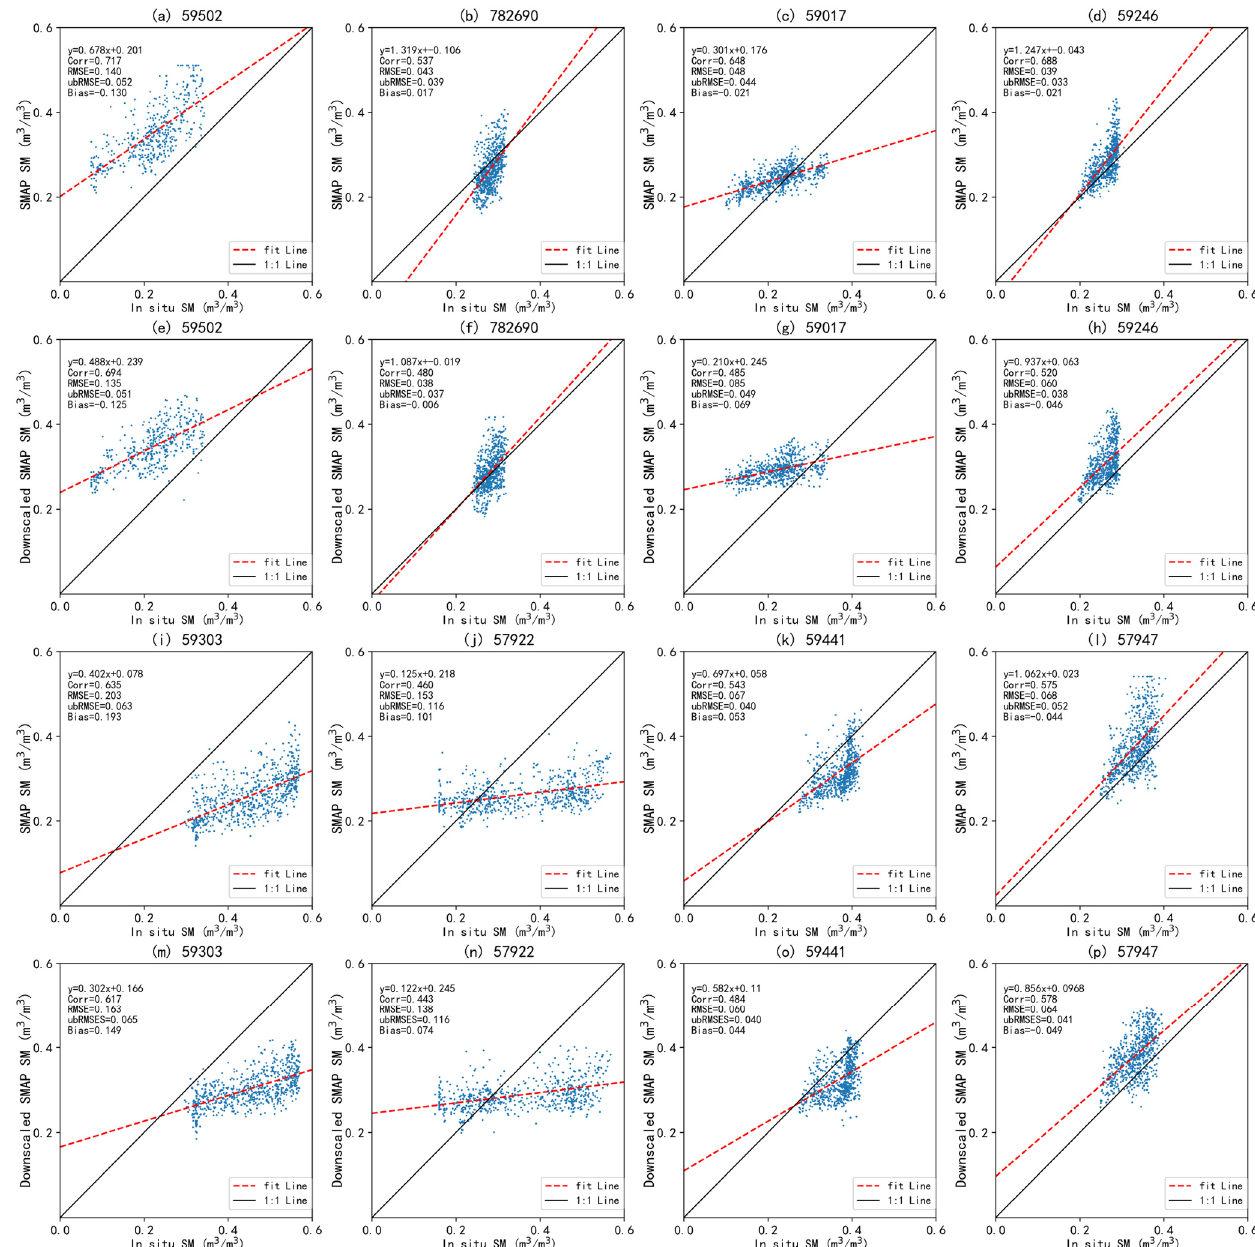
Figure 10. Scatters-plot of downscaled SM and in situ SM. The first and third row of scatter plots are generated by SMAP SM and in situ SM; the second and fourth row of scatter plots are generated by the downscaled SM and in situ SM.